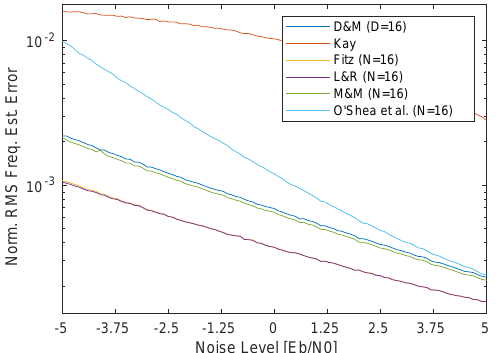
Figure 18. Frequency estimation noise detail ( D = 16; N = 16).